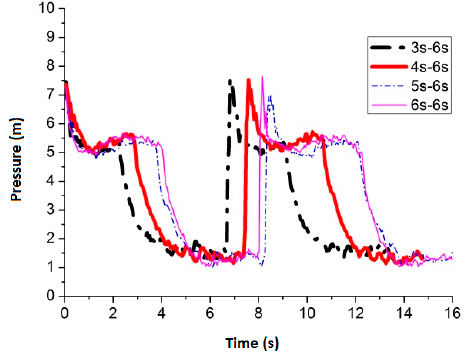
Figure 25. The four best pressure values when the slot nozzle is set on top of the pipe.